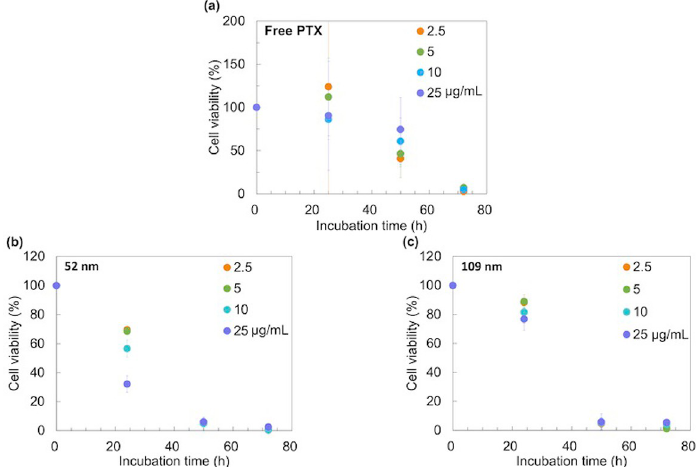
Fig 6. Cell viabilities dosed of (a) free-PTX, (b) 52 nm-sized blend-PTX NPs, and (c) 109 nm-sized blend-PTX NPs. Concentrations of PTX varied from 2.5 to 25 μ g/mL. Preparation conditions for blend-PTX NPs: C polymer = 5 mg/mL, TFR of 50 or 500 μ L/min and the FRR of 3. The error bars represent the standard deviations calculated from the repeated NP preparation experiment at least three times.